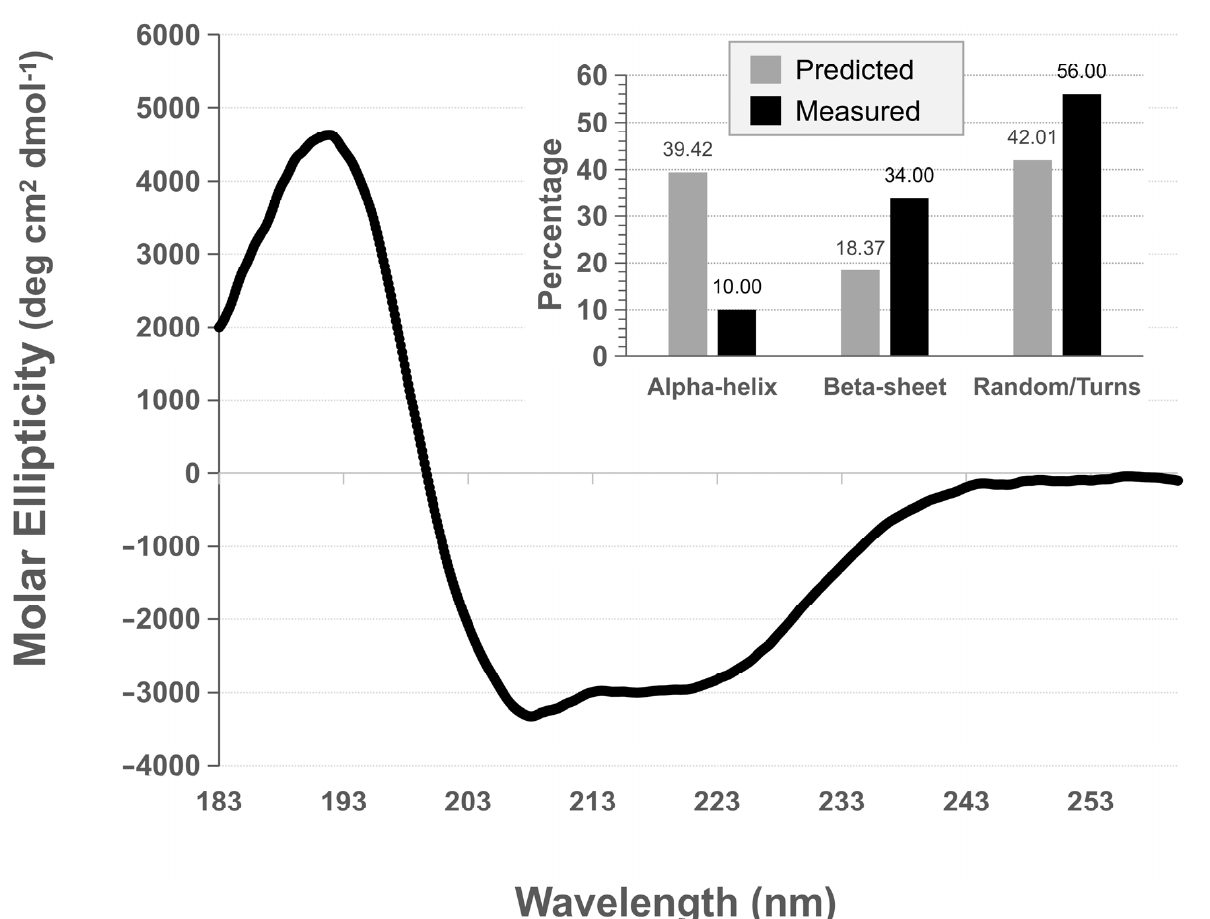
Figure 6. Analysis of secondary structure using circular dichroism. Circular dichroism spectrum and percentages of each class of secondary structure, according to in silico prediction and as measured by circular dichroism after deconvolution.